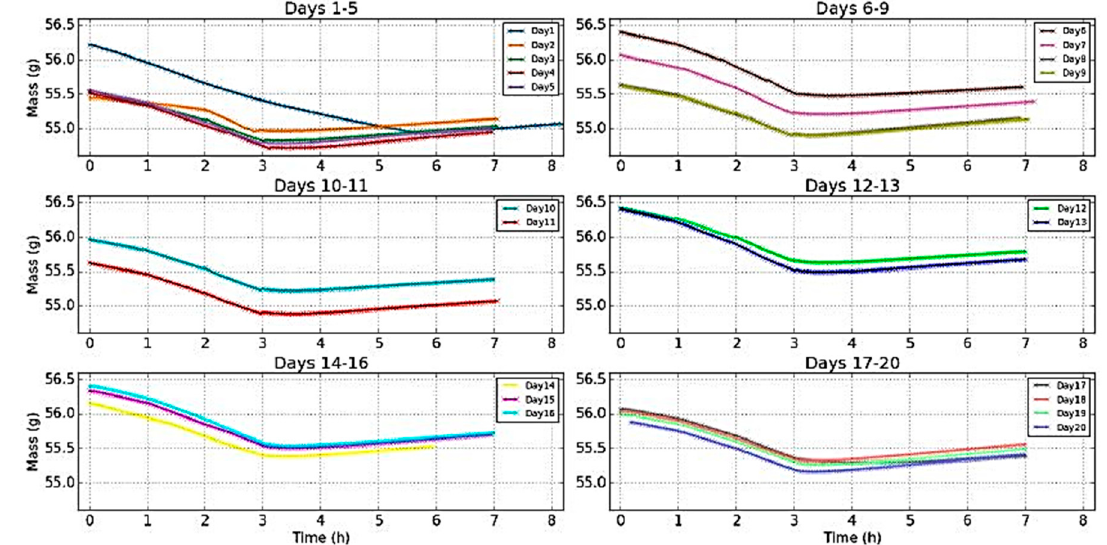
Figure 13. Evolution of the mass during the twenty days of Figure 13 . Evolution of the mass during the twenty days of experiments .